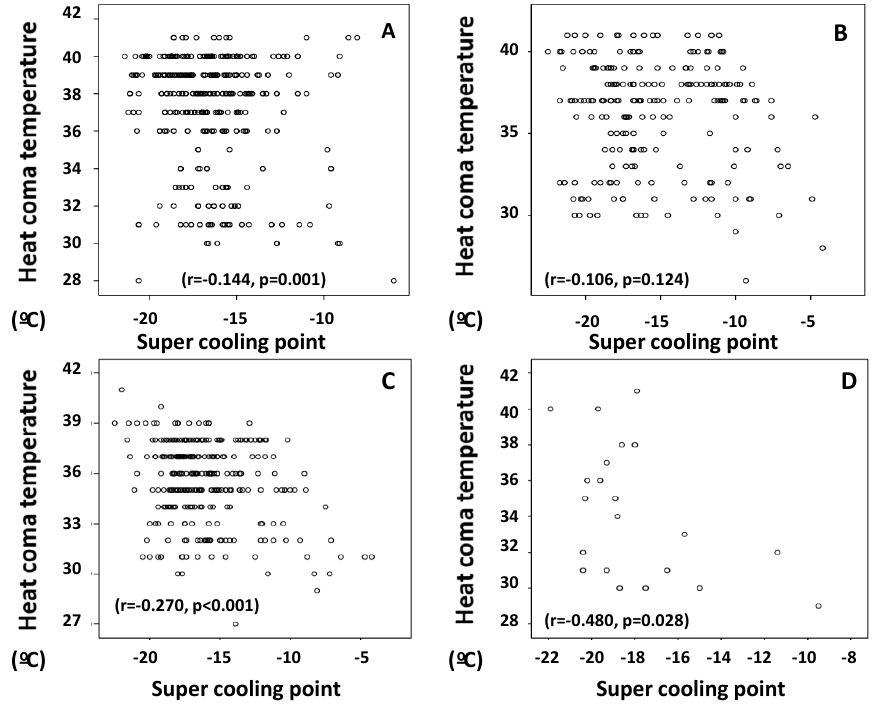
Figure 2. Negative correlation between heat coma temperatures (HCTs) and super cooling points (SCPs) in each of four species of oceanic sea skaters— Halobates micans ( A ), H. germanus ( B ), H. sericeus ( C ), and H. sp. ( D )—inhabiting the temperate to tropical region of the Indian and Pacific Oceans.